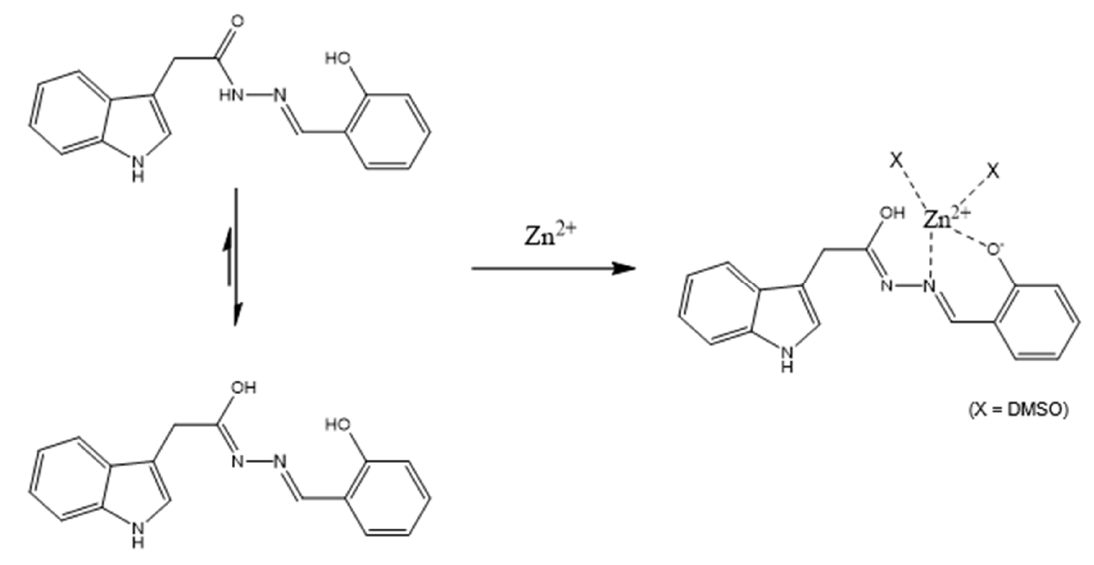
Figure 2. 1 H NMR titration of IH-Sal with Zn 2+ (0, 0.5, 2.0 and 3.0 equiv).